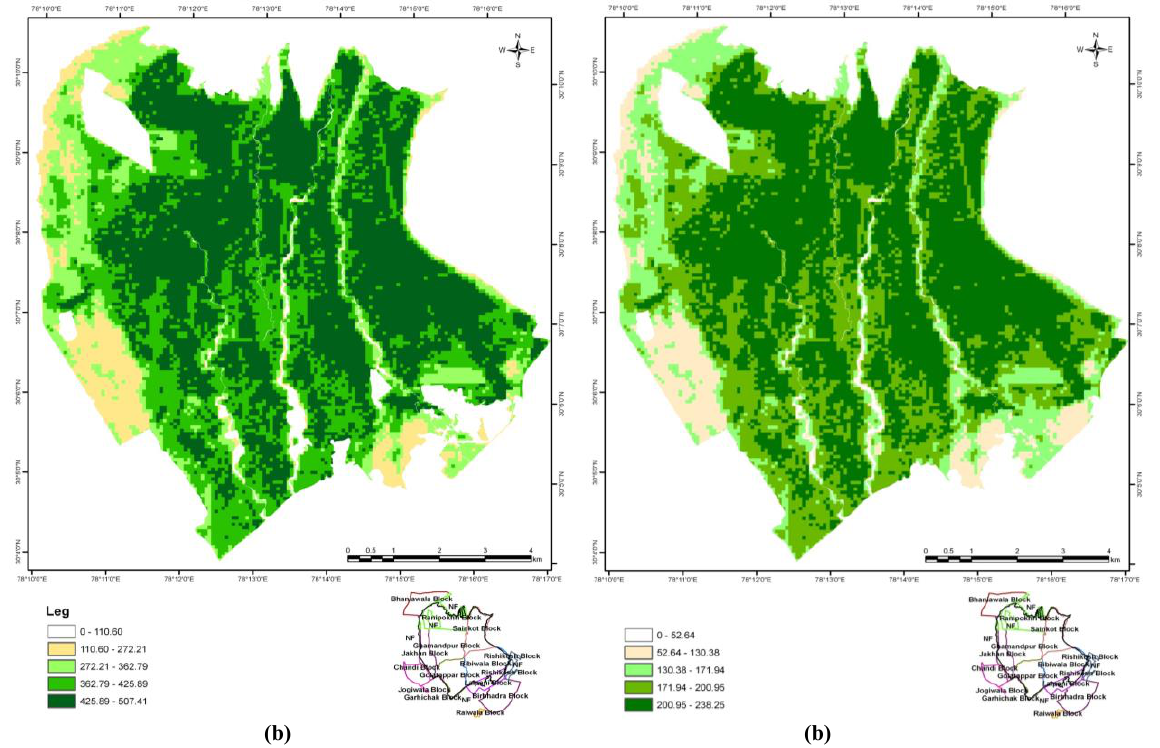
Fig. 5a Biomass and b Carbon in Barkot Forest